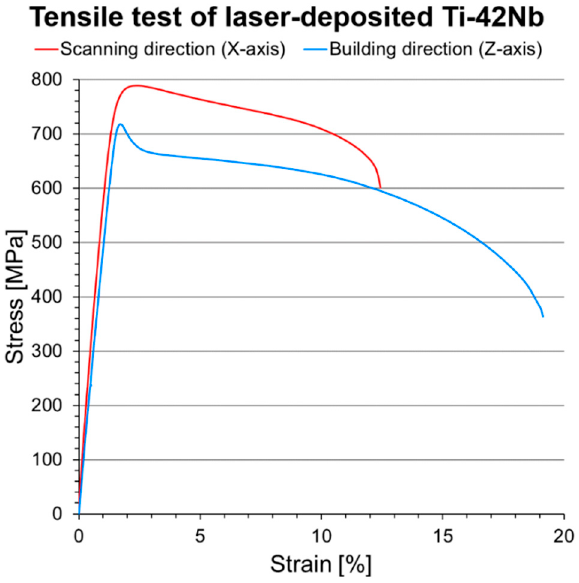
Figure 12. Representative engineering stress-strain curves of laser-deposited Ti-42Nb specimens in the scanning direction (X-axis) and building direction (Z-axis). Table 1. Mechanical properties of selected biomedical titanium alloys determined in tensile tests: